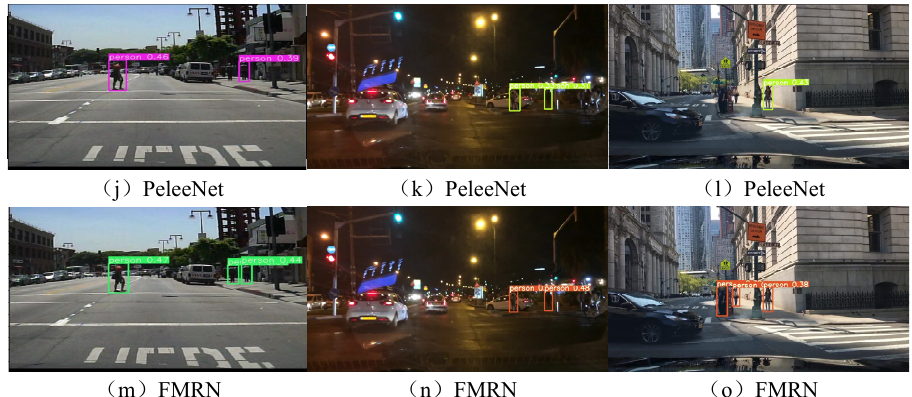
Figure 8. Visual comparison with previous state-of-the-art methods on Caltech and BDD 100 K- Person dataset.